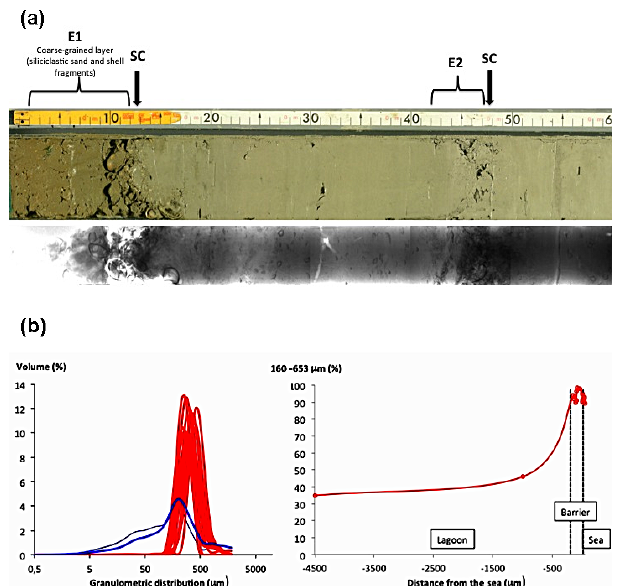
Figure 2. Panel (a) : photography and X-ray of the core MM2 (0 and 60cm). Coarse-grained layers are a mixture of siliciclastic sand and shell fragments. These layers often have sharp contacts (SC) with the clay and silt sediments below. Panel (b) : granulometric distri- bution of surface samples collected on an E–W transect from the sea and the barrier (red) to the lagoon (blue). Evolution of the 160– 653µm population from the sea to the lagoon in surface samples.